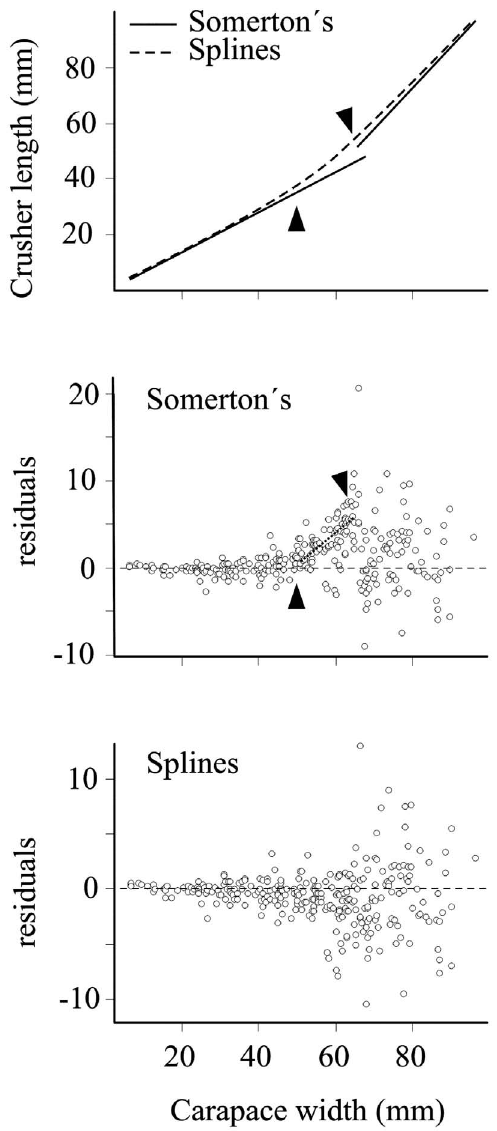
Fig. 7. – Top: the splines model and the Somerton’s model applied to growth of the propodus length of the crusher chela (CrL) in males of Platyxanthus crenulatus . Middle: residuals from Somerton’s model. Bottom: residuals from splines. Note that Somerton’s re- siduals can be divided into three well-defined moments (indicated by black arrows and the dotted